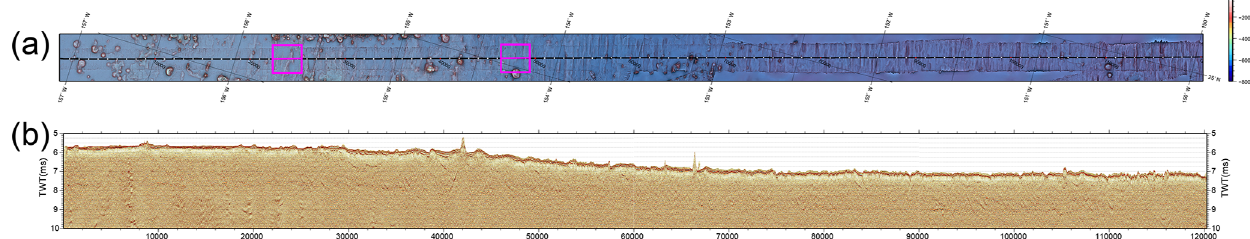
Figure 4. (a) Detailed bathymetry image along the EW line. Pink boxes show the location of Figs. 3 and 4. (b) Prestack time-migrated section of the EW